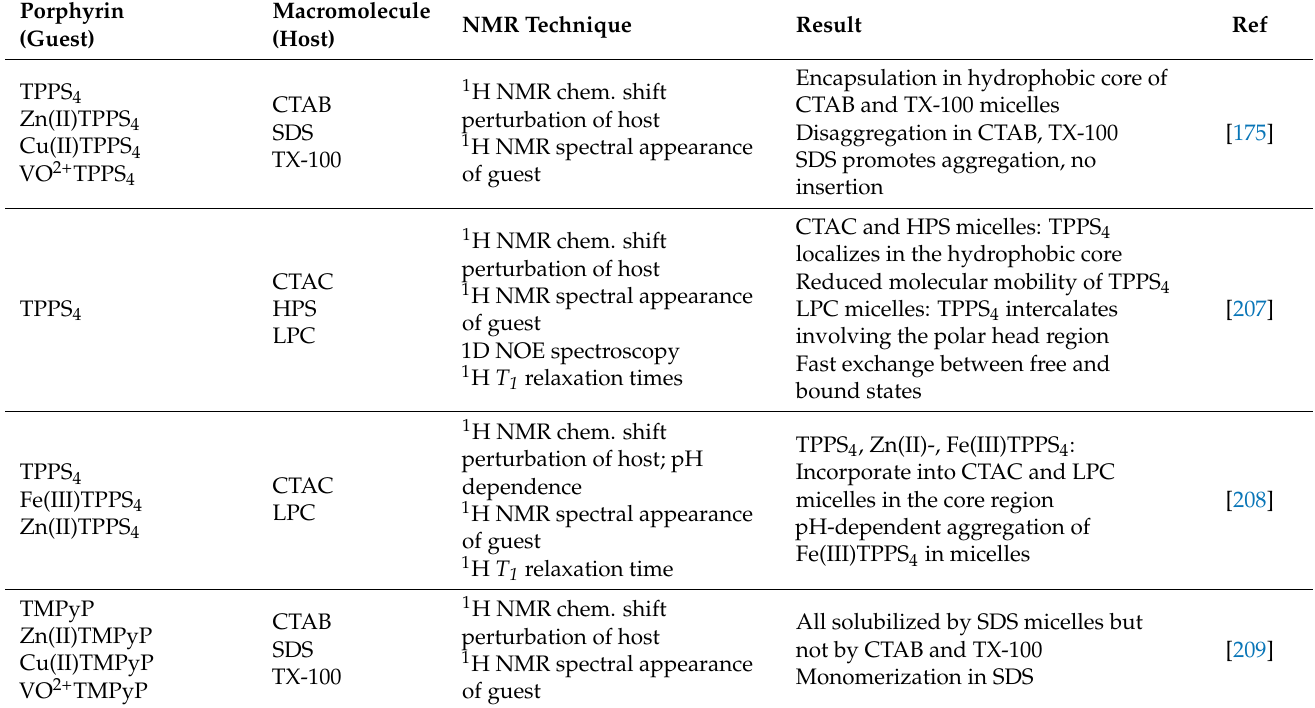
Table 4. Summary of NMR interaction studies between porphyrins and surfactant micelles.